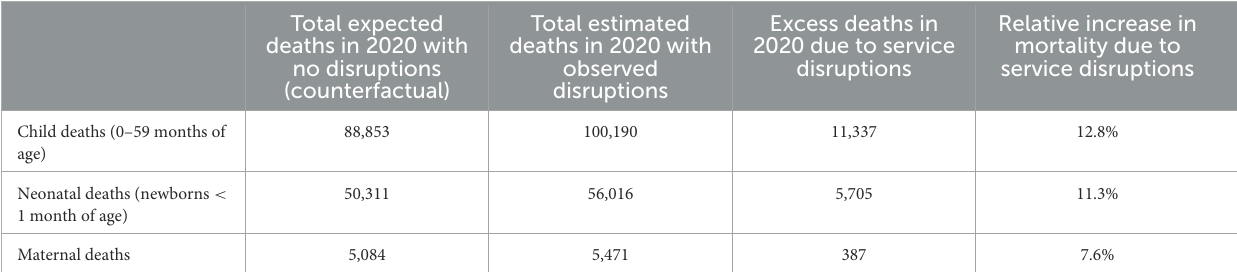
TABLE 6 Mozambique’s relative reduction in service counts, by indicator and month for 2020 and first quarter of